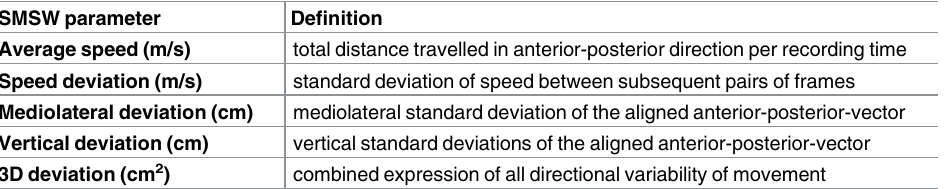
Table 2. SMSW parameter